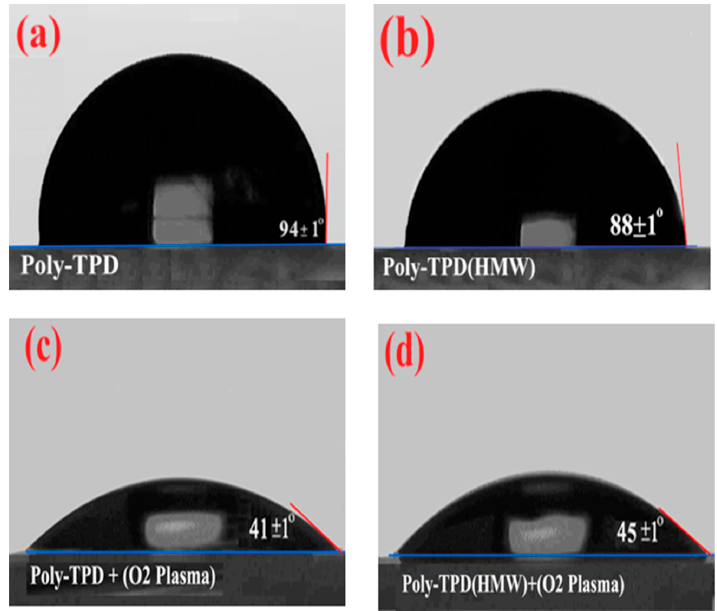
Figure 7. Water contact angle of ( a ) Poly-TPD, ( b ) Treated Poly-TPD High Molecular weight (HMW), ( c ) Treated Poly-TPD with O 2 plasma, and ( d ) Treated Poly-TPD (HMW) with O 2 plasma.